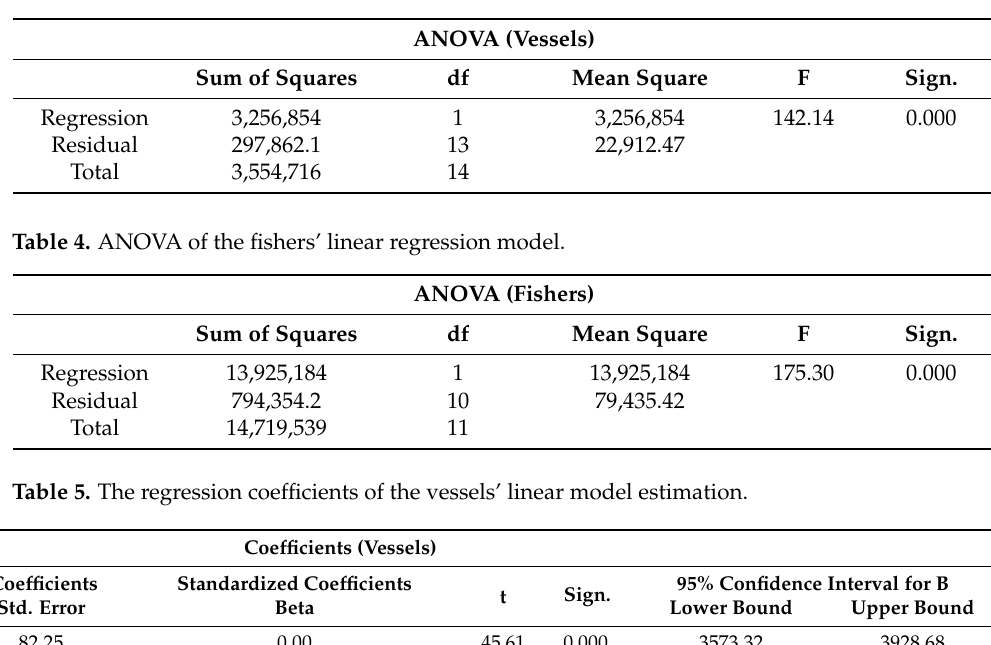
Table 3. ANOVA of the vessels’ linear regression model.